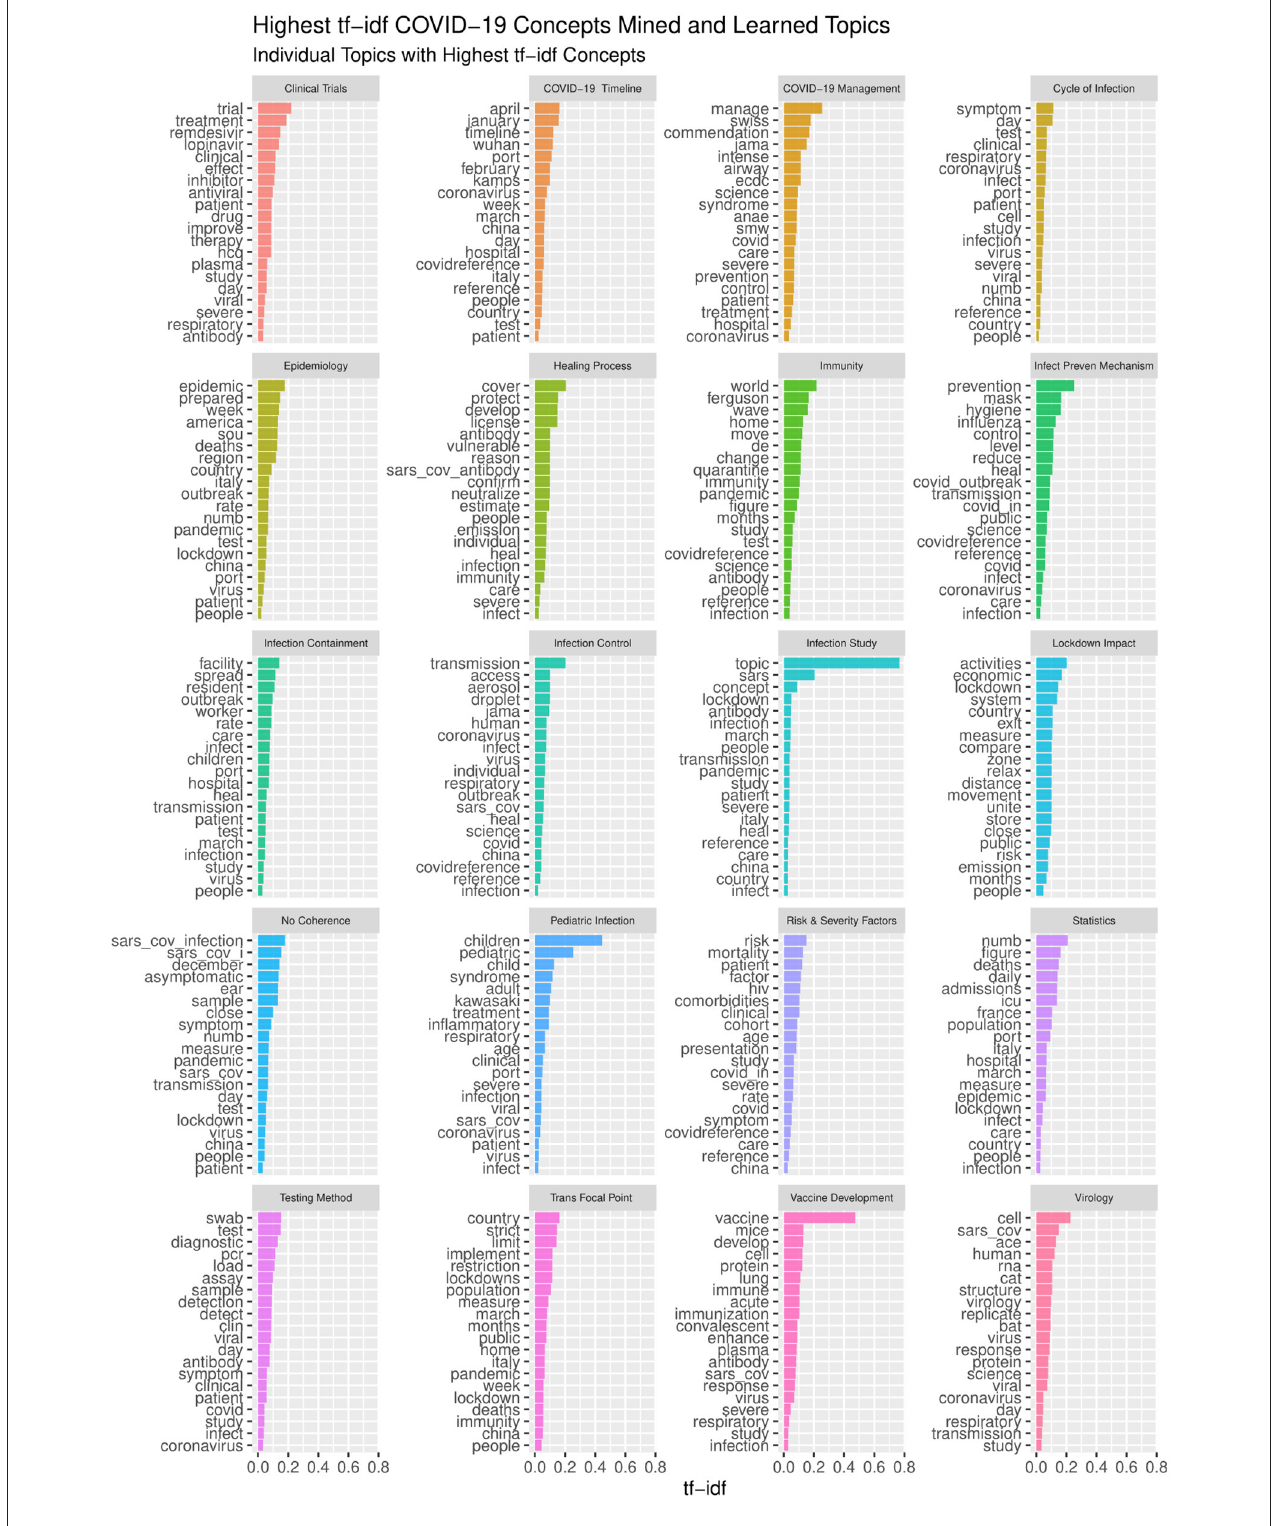
FIGURE 7 | The highest 20 topics mined from the COVID-19 book.